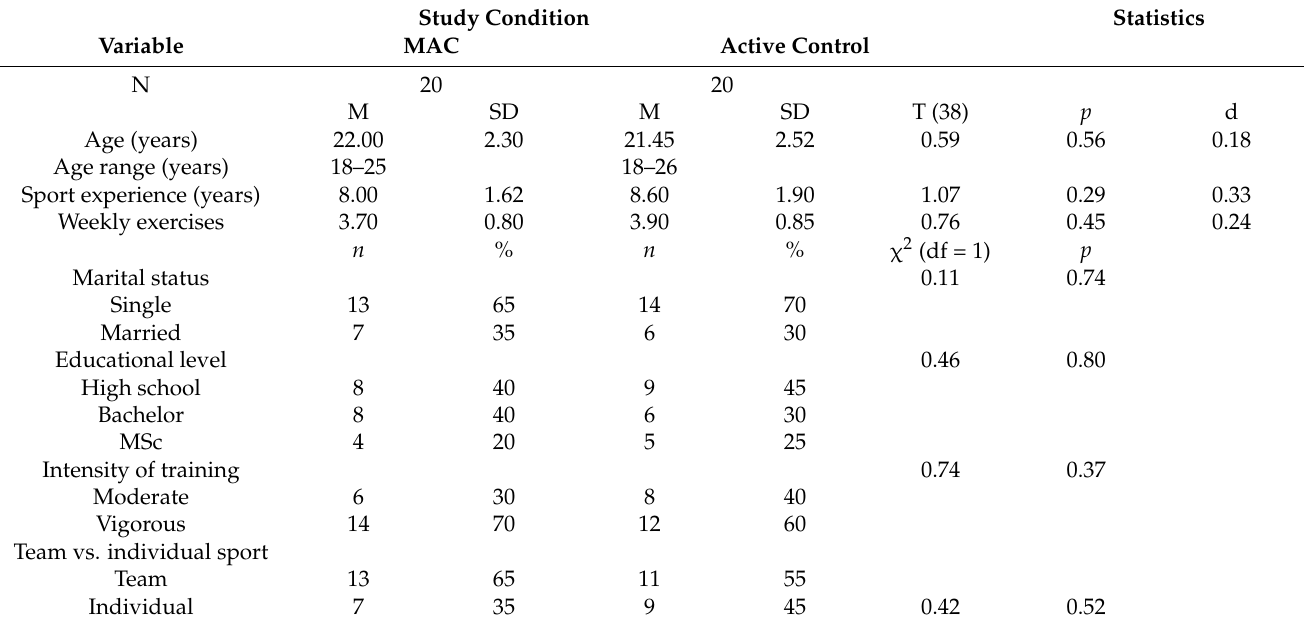
Table 2. Descriptive and inferential statistical overview of sociodemographic baseline characteristics between participants in the MAC and active control